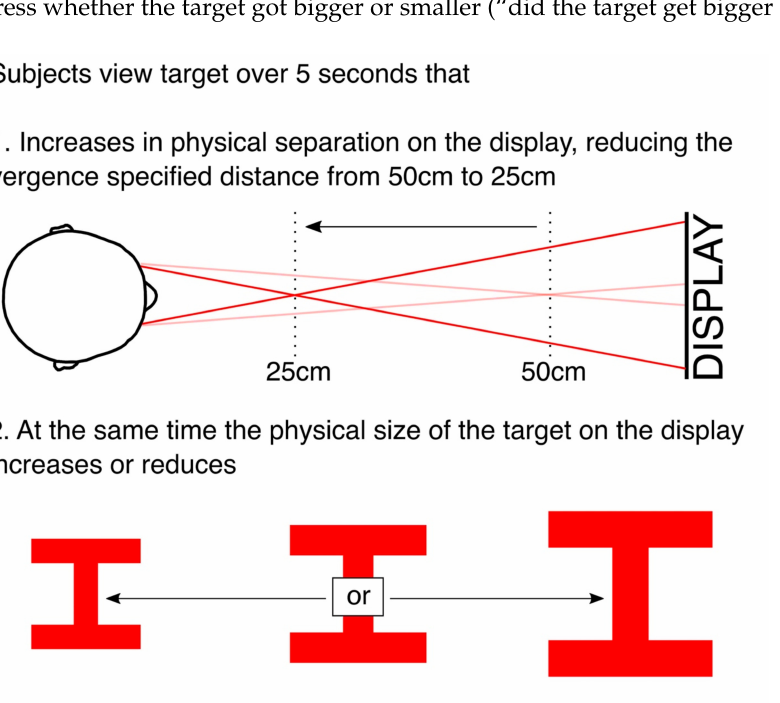
Figure 3. Summary of the two simultaneous manipulations of the targets during each trial of (1) the physical separation of the targets on the display, that manipulated the vergence specified distance of the target, and (2) the physical size of the targets on the display. Participants were asked to judge whether the target got bigger or